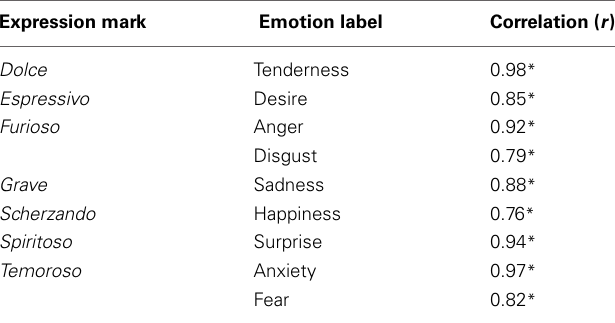
Table 2 | Examples of correlations between commonly used expression marks in music scores and basic-emotion labels used by